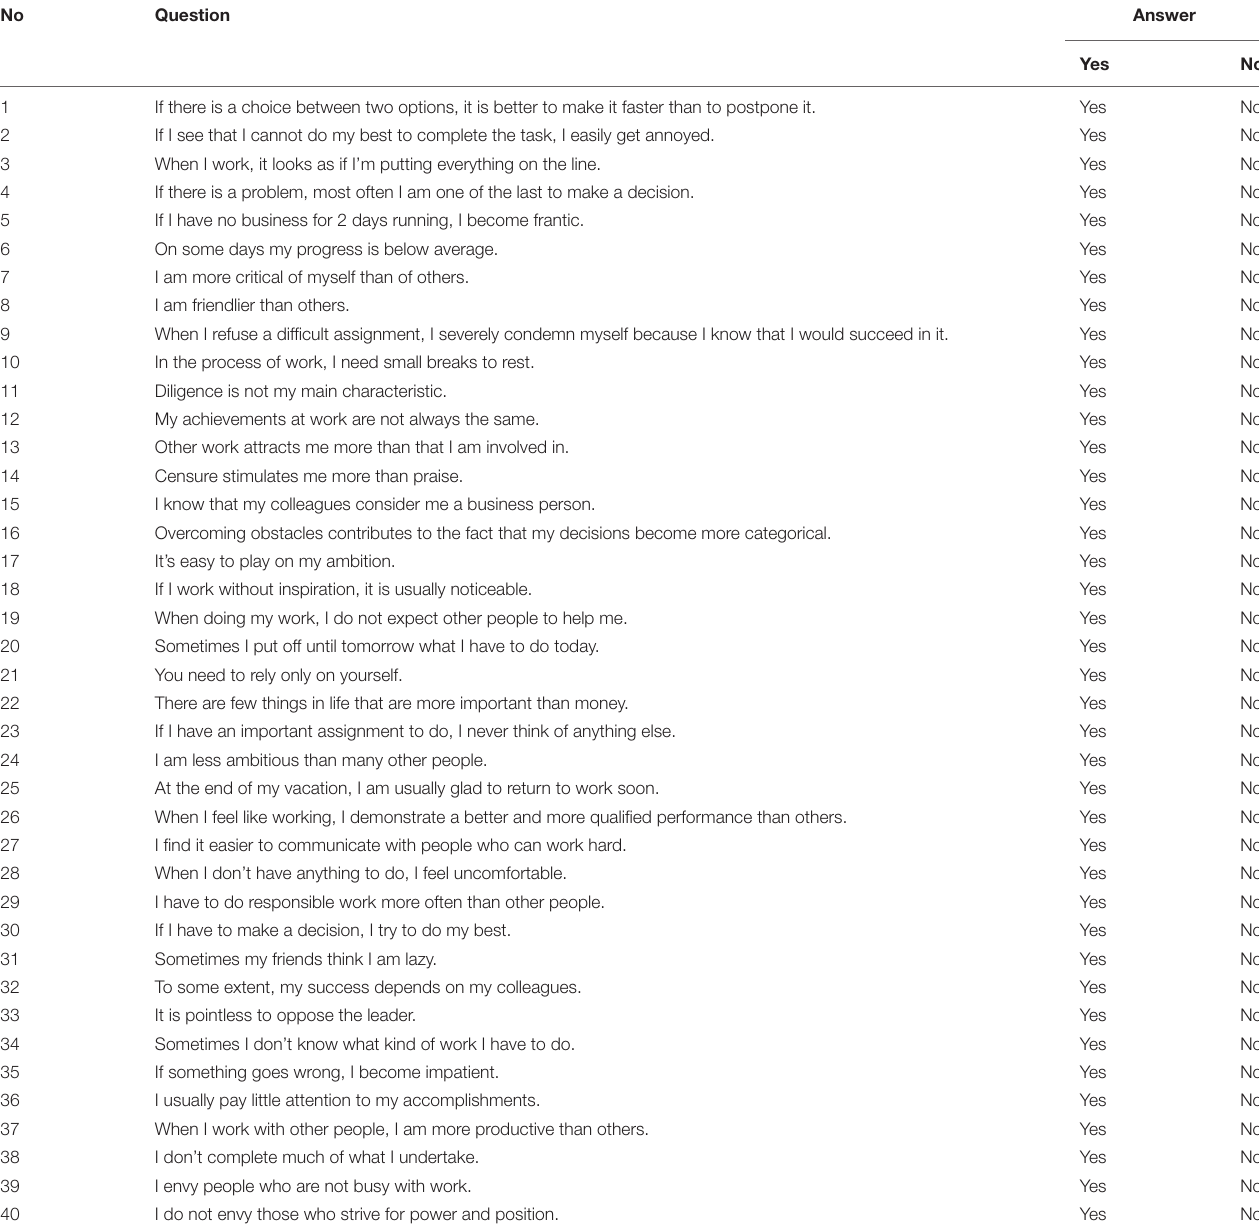
TABLE A1 | Dear social educator! We would like you to kindly answer the questions of the questionnaire in the framework of the research initiated by the Al-Farabi Kazakh National University and Abai Kazakh National Pedagogical University. For your information, you are asked 41 questions to be answered in the positive or in the